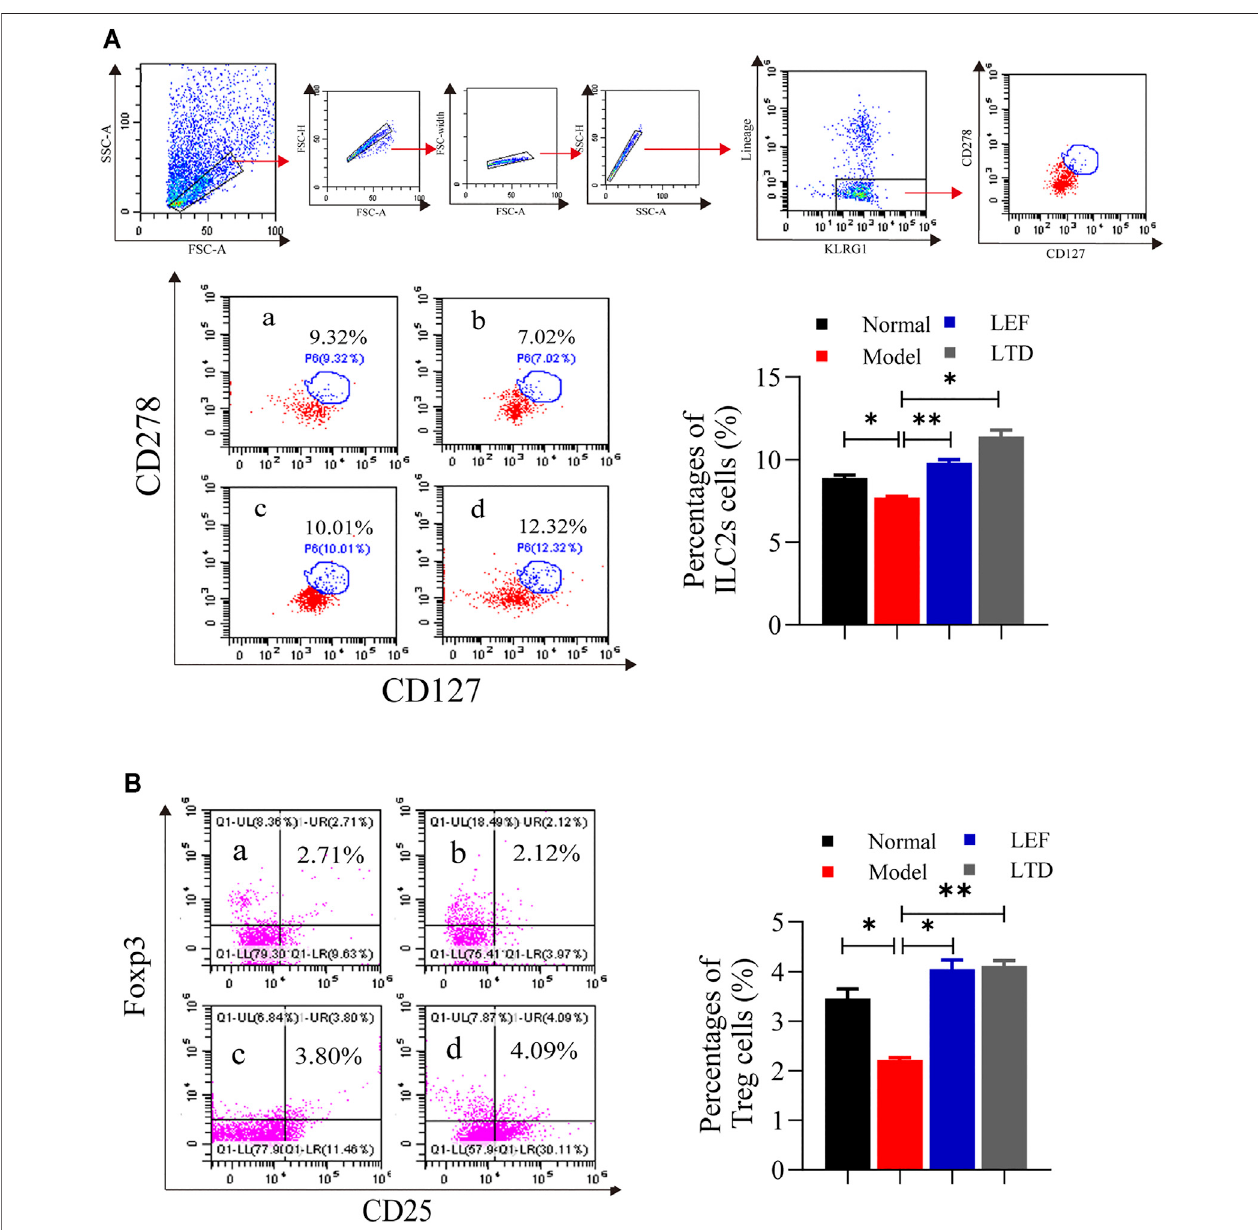
FIGURE5| ThepercentagesofILC2s cellsandTregcells. (A) Ascatter plotofrepresentativeILC2scells. (B) Ascatter plotofrepresentativeTregcells.Theresults are presented in the bar charts ( n (cid:1) 3). a: normal group, b: model group, c: LEF group, d: LTD group. Data are presented as the means ± S.D.* p < 0.05,** p < 0.01.